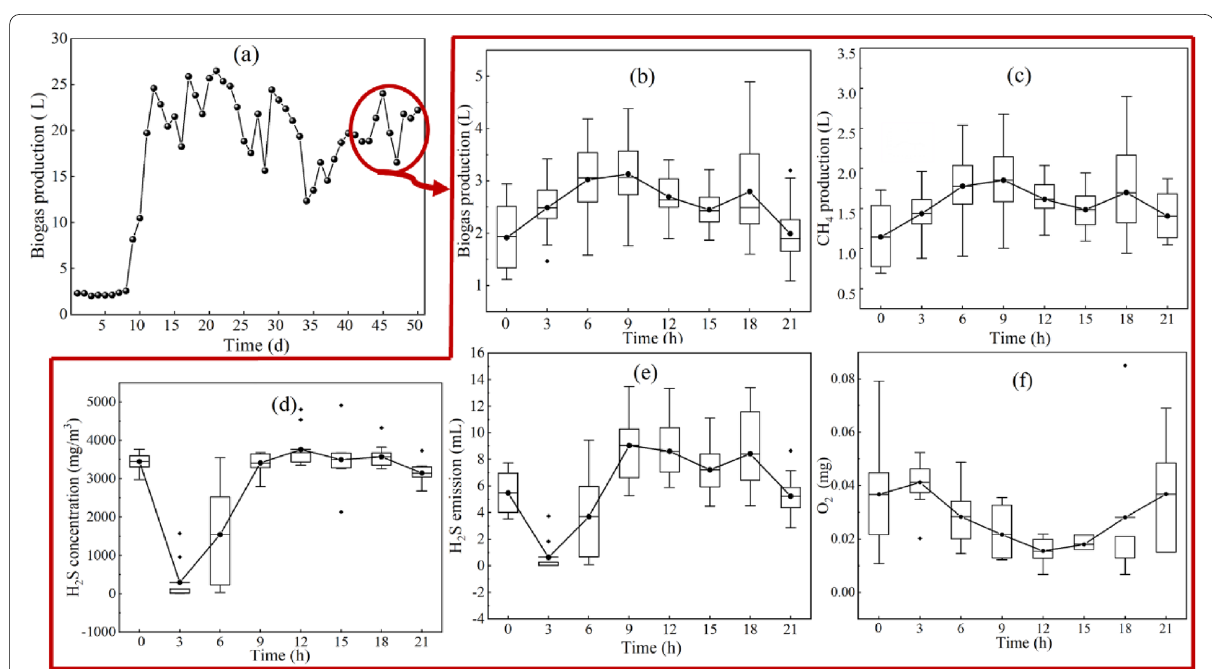
Fig. 2 Characteristics of fermentation gas generated by a CSTR: a daily production of 50 d biogas; b production of biogas under a monitoring frequency of 1 point/3 h; c CH 4 production; d H 2 S concentration; e H 2 S production; f O 2 mass in biogas. Note:0 h means the time before feeding and the time at 24